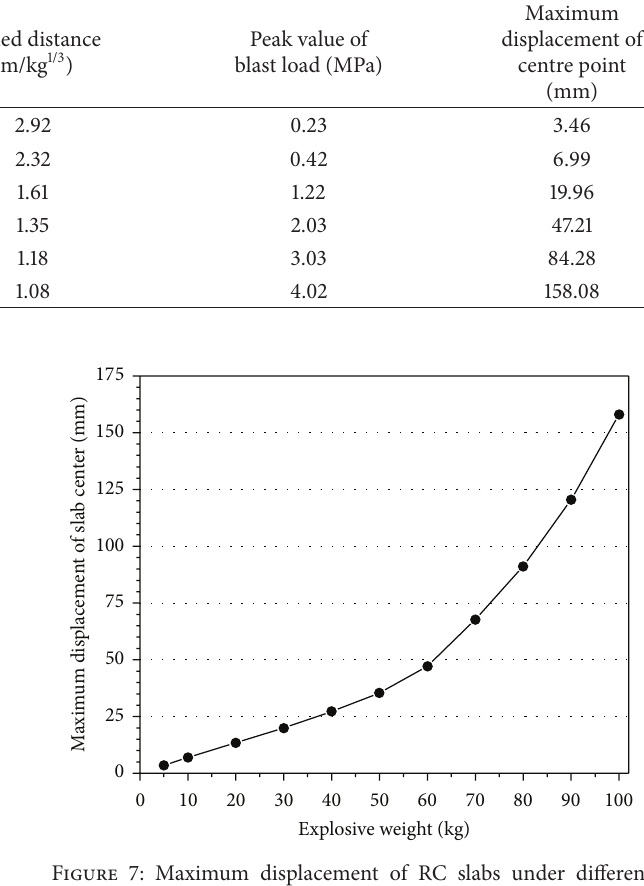
Table 1: Maximum displacement of RC slab under different explosive charges.